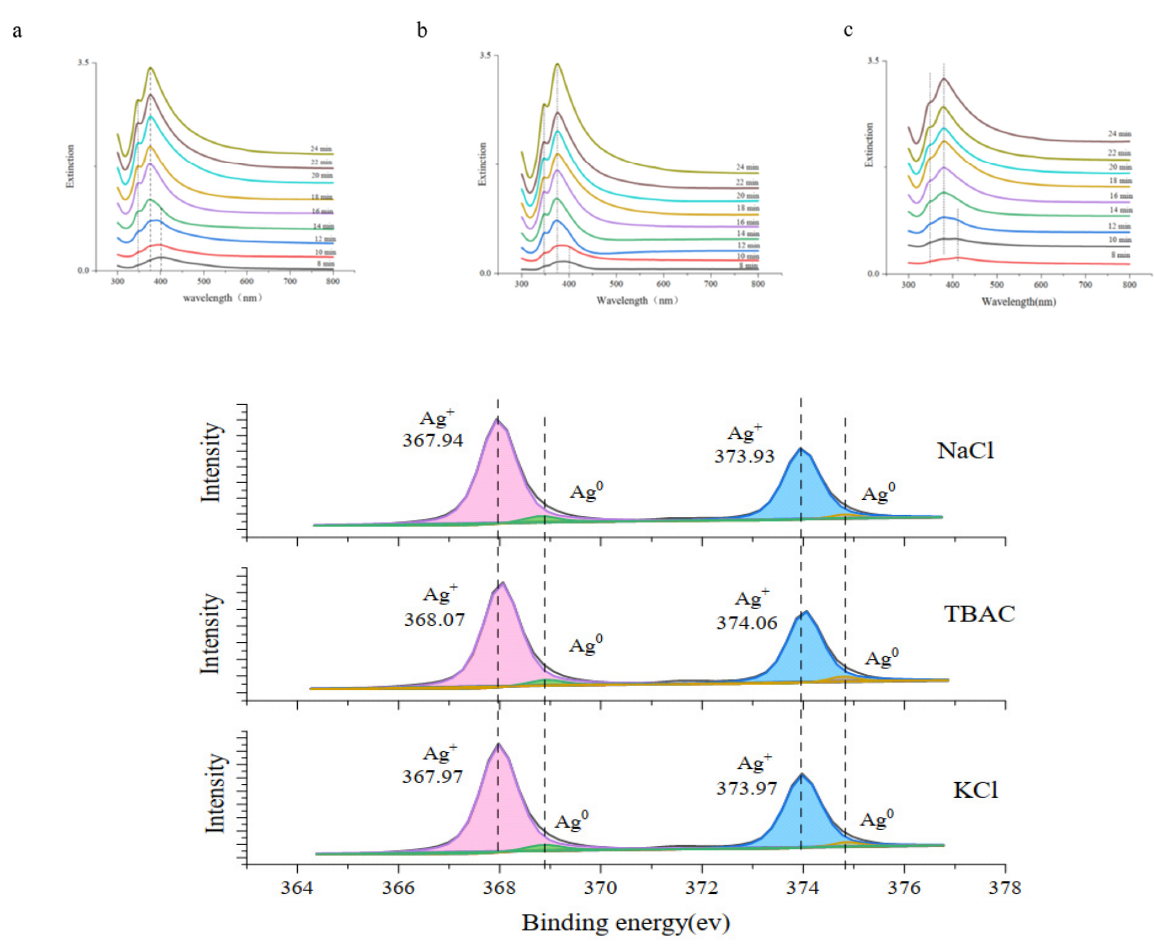
Figure 3. UV extinction spectra of AgNWs prepared under the addition of NaCl ( a ), TBAC ( b ) and KCl ( c ) with time. ( c ) The XPS spectra under the addition of NaCl, TBAC and KCl in the 10th